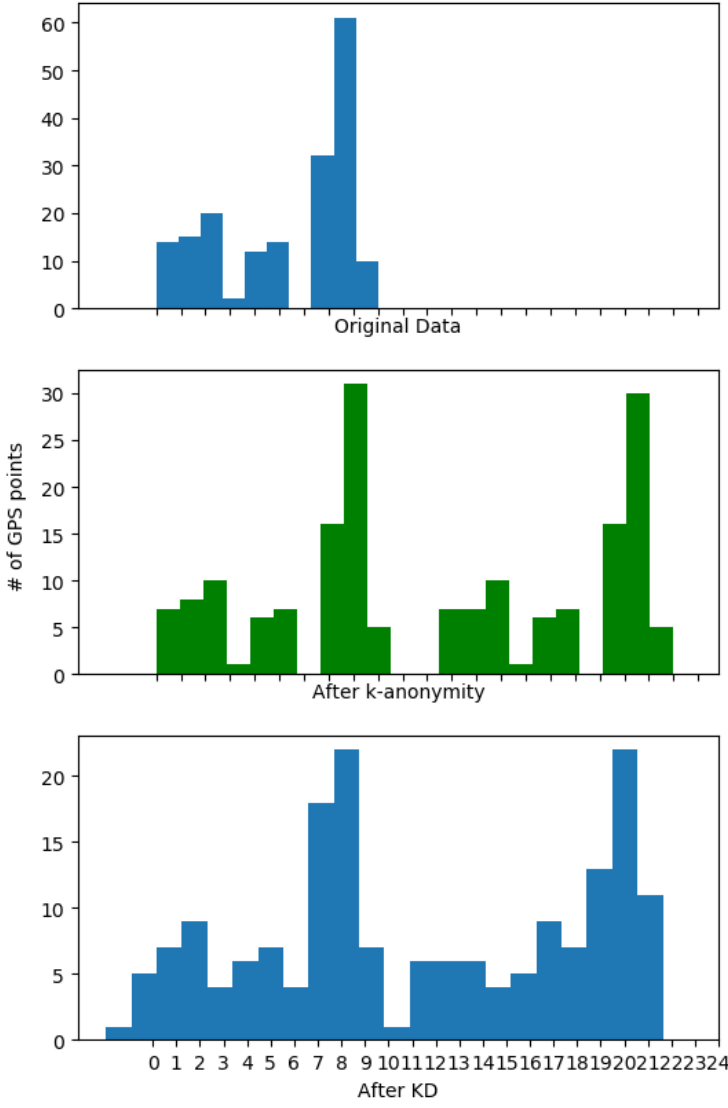
Figure 3. TDP for Geolife Trajectories dataset.